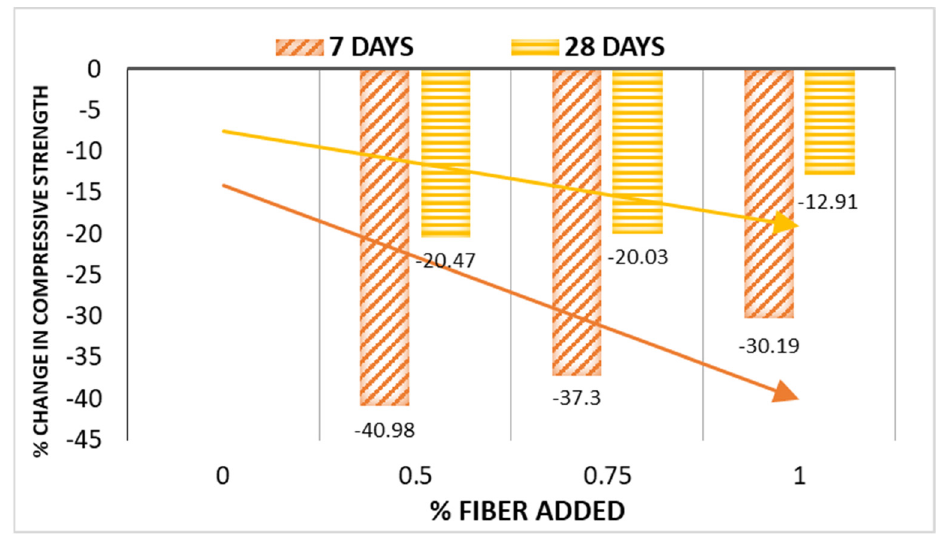
Figure 12. Percentage changes of compressive strength with varying wire percentage.